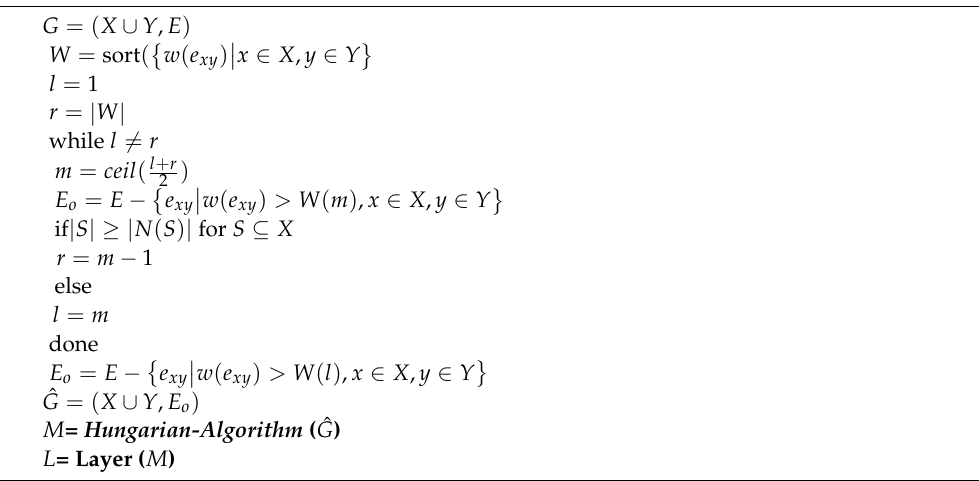
Algorithm 2. Pseudocode for the proposed Fair Hungarian